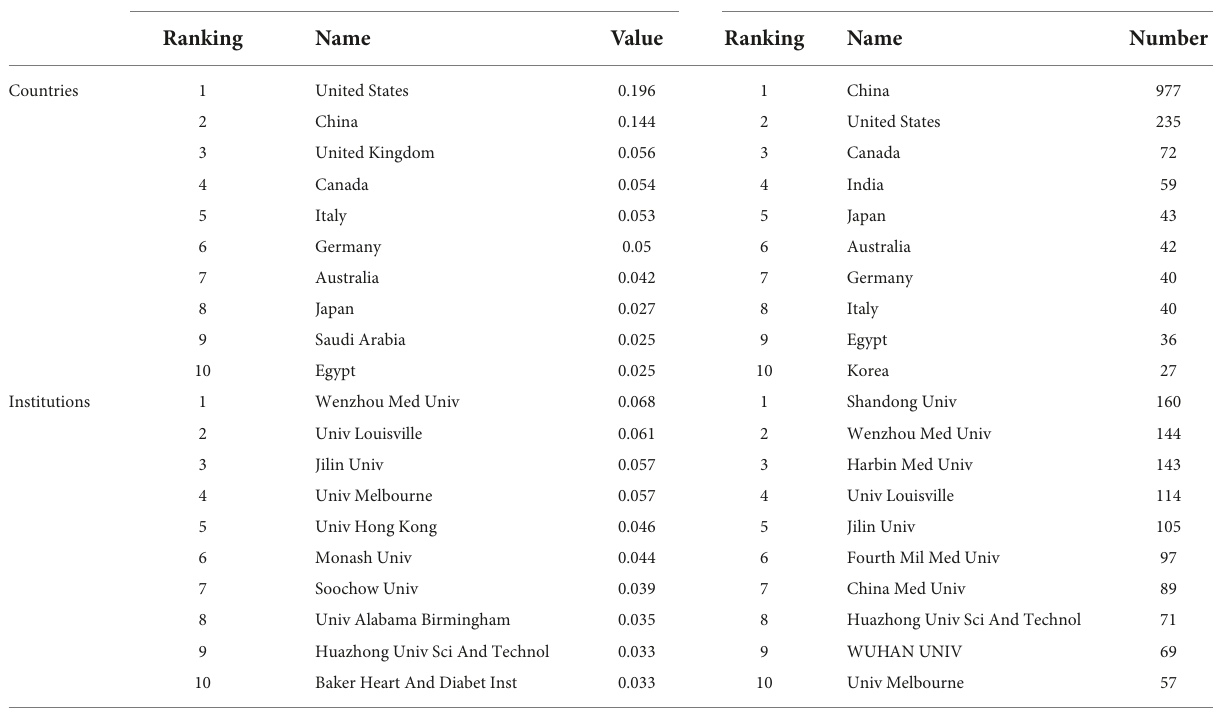
TABLE 1 Top 10 countries and institutions in terms of PageRank and